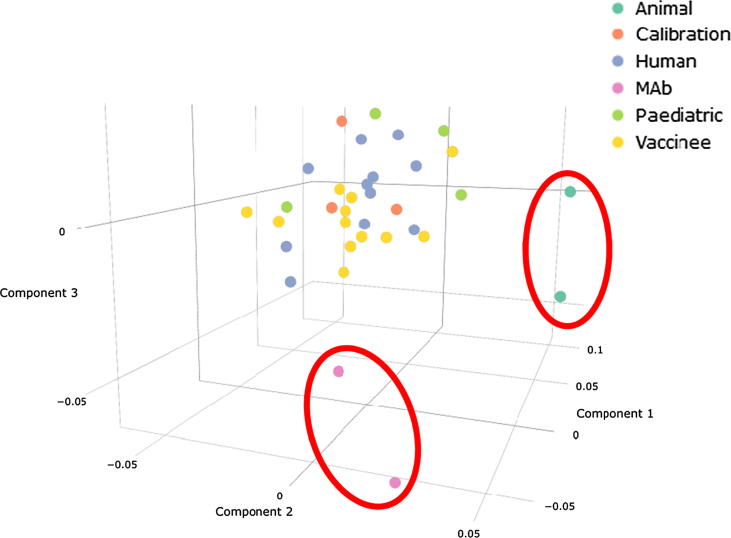
Correspondance analysis scatterplot. Scatterplot of row (sample) principle coordinates from correspondence analysis. Samples exhibiting similar patterns in results across different laboratories will lie in close proximity on the plot.